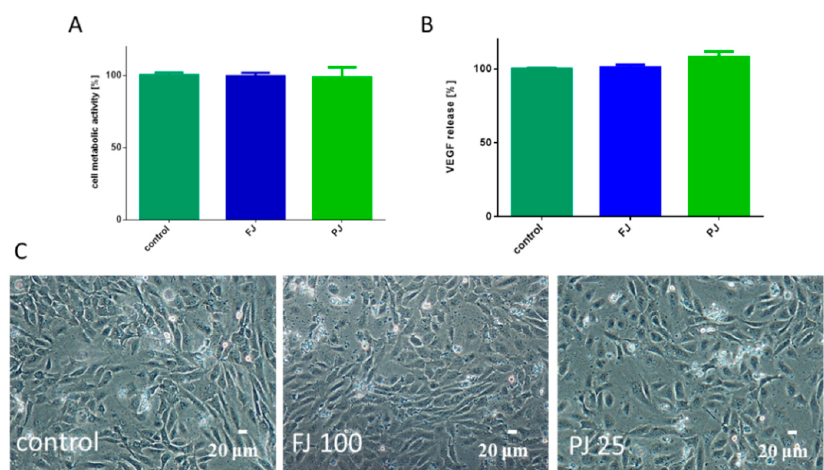
Figure 10. The influence V. opulus FJ and PJ at IC 0 concentration on cellular metabolic activity, determined with Presto Blue assay ( A ) and VEGF secretion quantified with ELISA ( B ) by HUVEC cells; control cells were not exposed to any compound; values are means ± SEM, n ≥ 3. Morphology of HUVEC cells treated with V. opulus for 48 h ( C ); randomly chosen fields were photographed at × 200